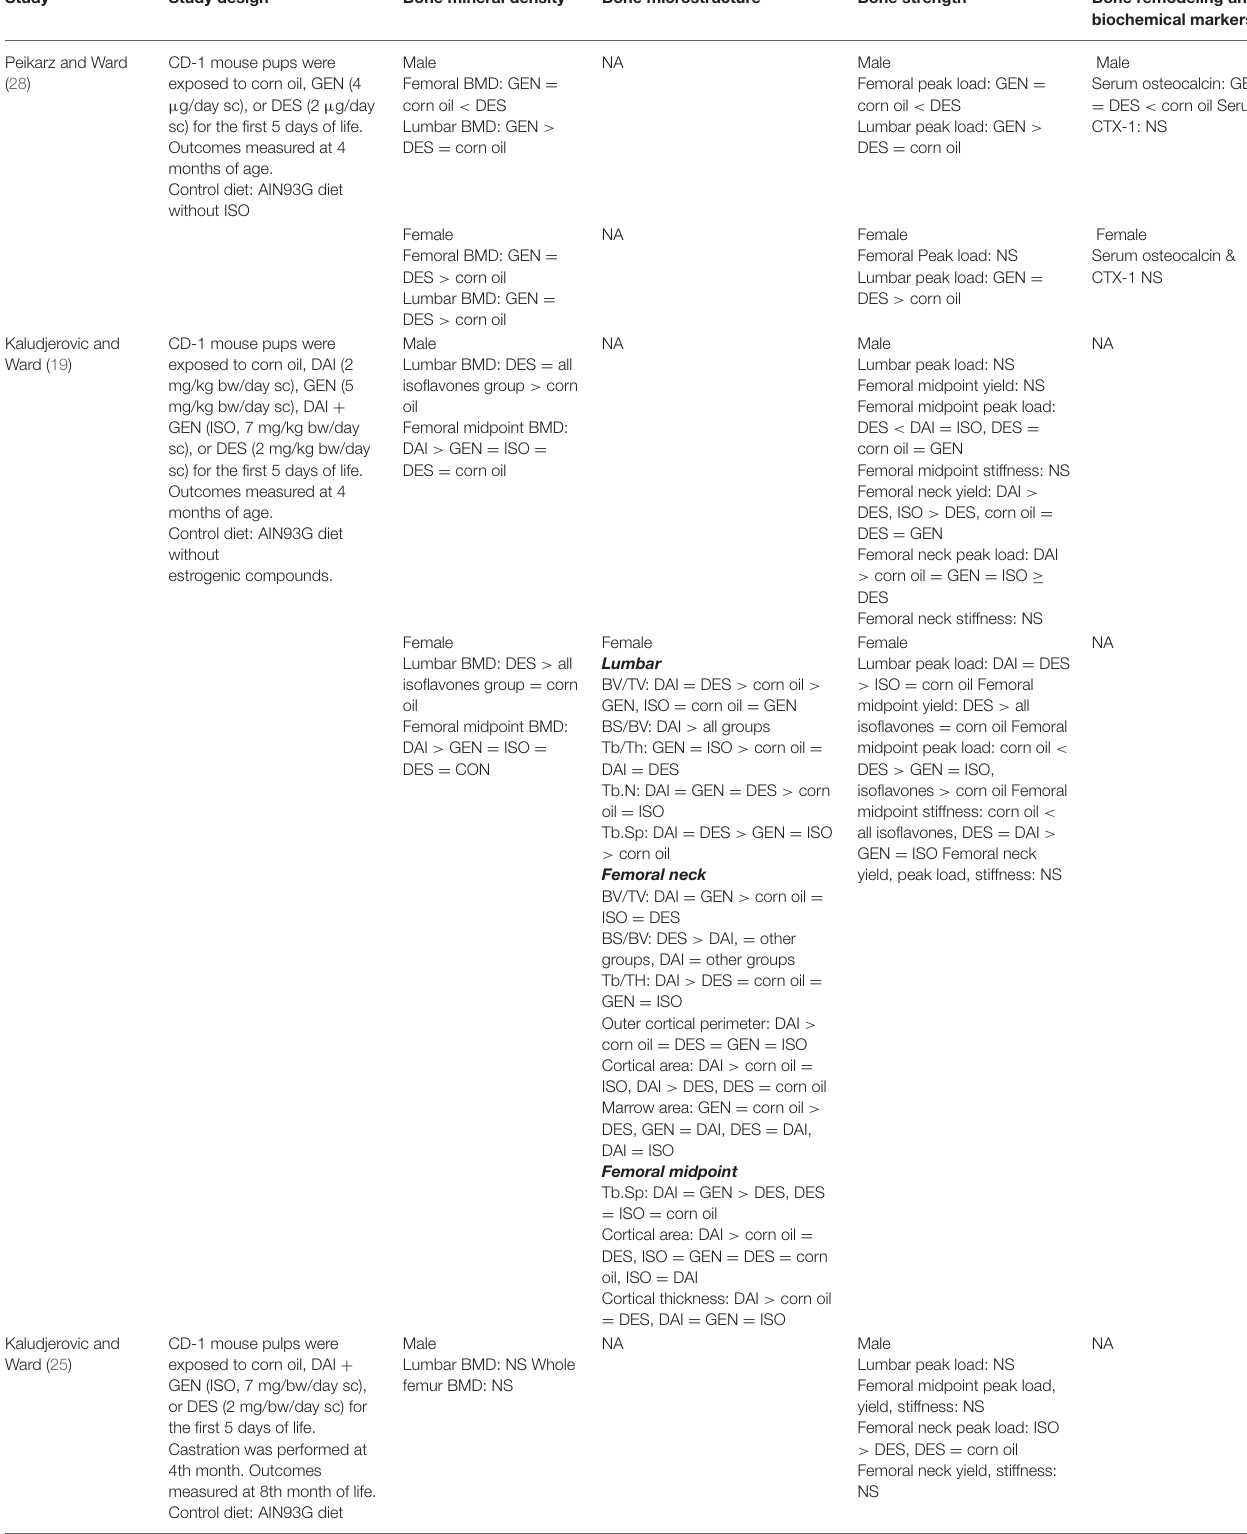
biochemical markers